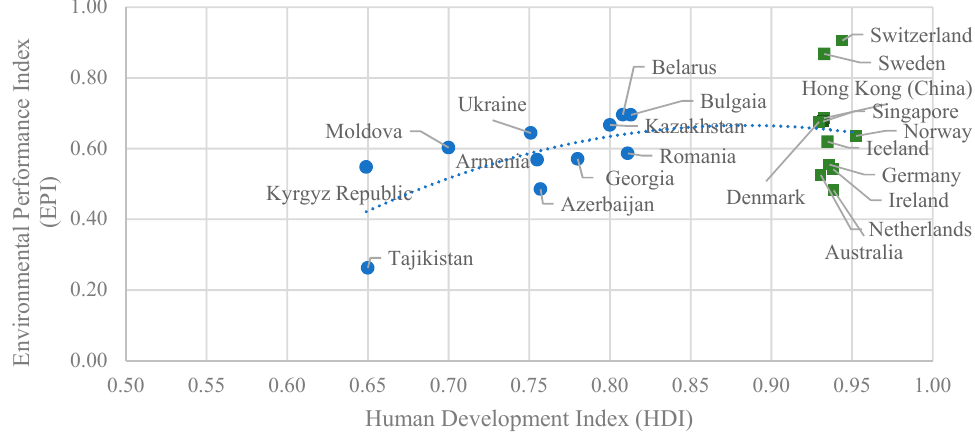
Figure 2. Correlation matrix between the Environmental Performance Index (EPI-2018) and the Human Development Index (HDI-2017). Sources: The Environmental Performance Index (2018) and Human Development Index (2017).